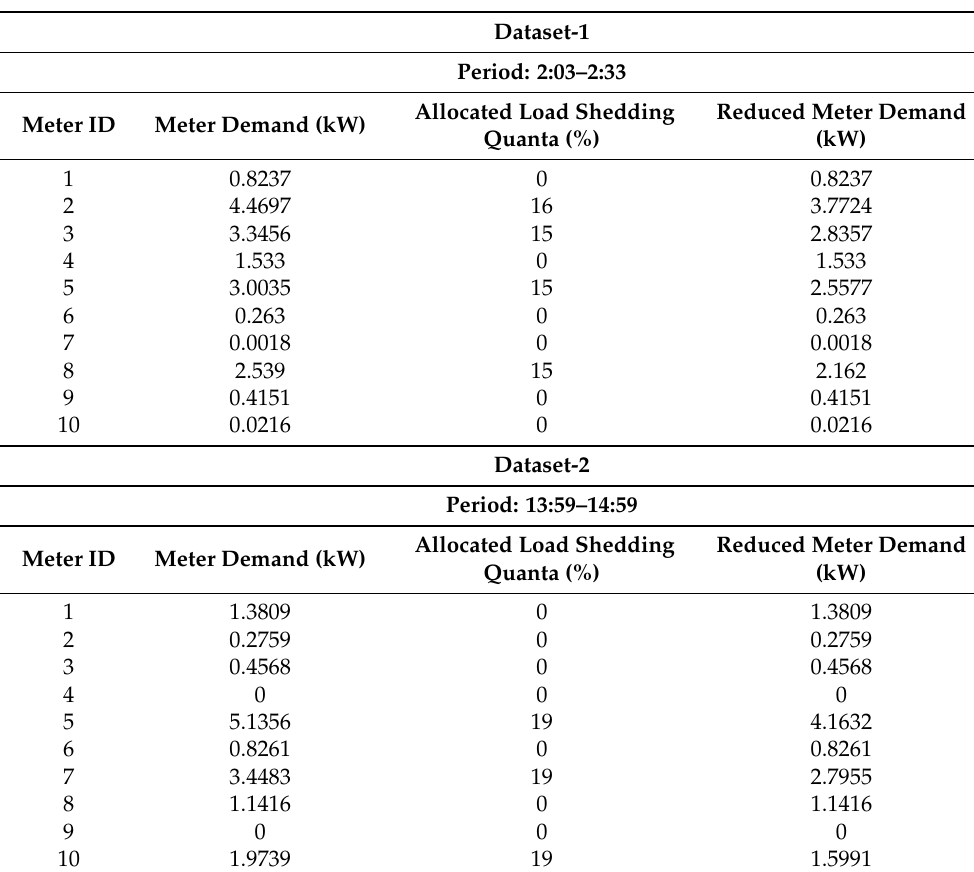
Figure 6. Demand and supply profile during shortfall after SLS for data set-1. Table 1. Allocated percentage quanta of load shedding for different